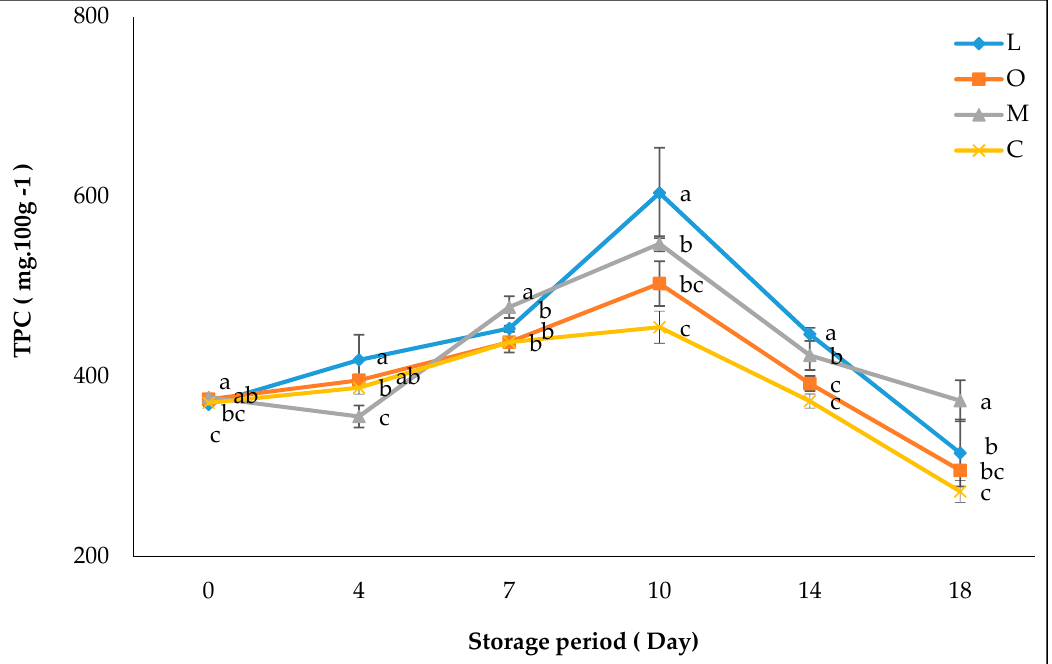
Figure 9. Effect of different essential oil emulsions (L = lemon, O = orange, and M = mandarin essential oil) on total phenol content (TPC) of strawberry fruits stored at 2 °C for 18 days. Vertical bars indicate the standard deviation (n = 6). Means and different letters indicate significant difference between treated and control fruits at each storage period (Duncan’s of 95%).